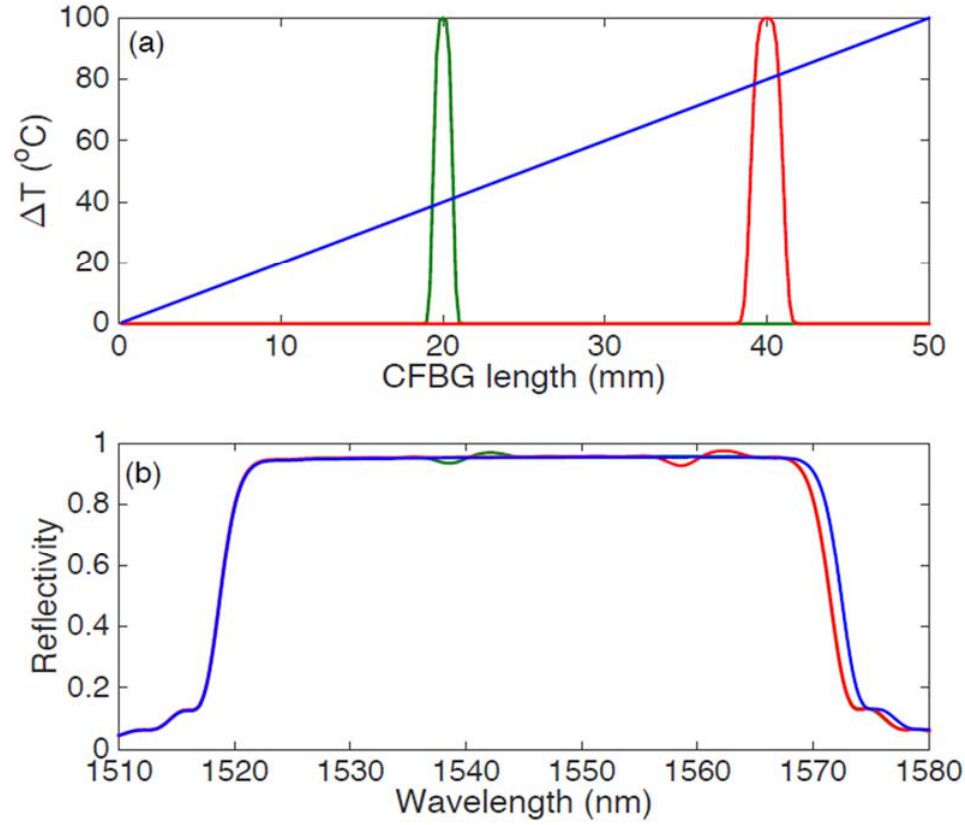
Figure 3. Simulation of the variations of CFBG spectra with CMT model, exposed to different temperature pattern. ( a ) Temperature variations applied to a 50-mm long CFBG with 1 nm/mm chirp rate; ( b ) Obtained CFBG reflection spectrum for each temperature profile. Each profile is displayed with the same color in the two charts.